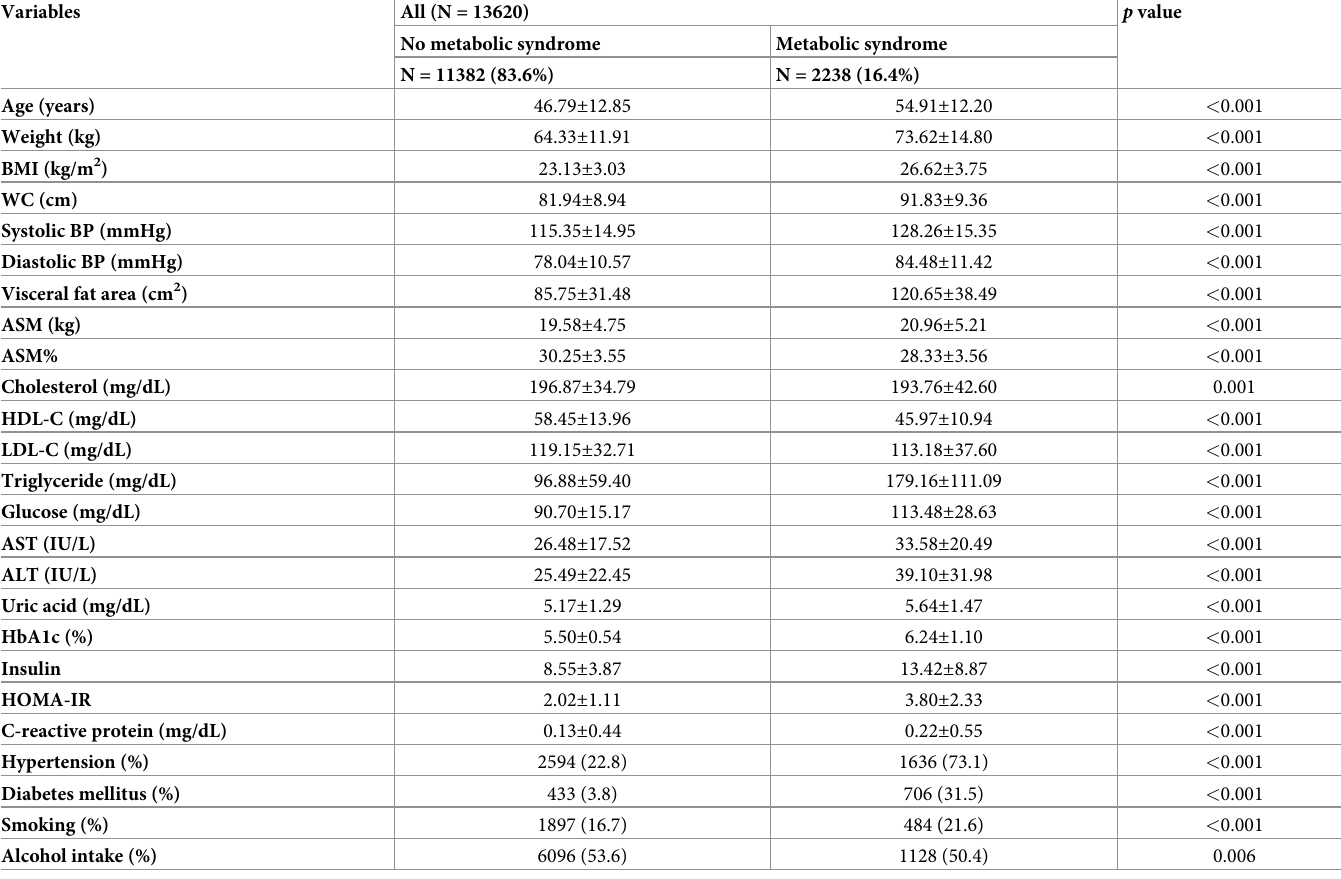
Table 1. Clinical characteristics according to metabolic syndrome